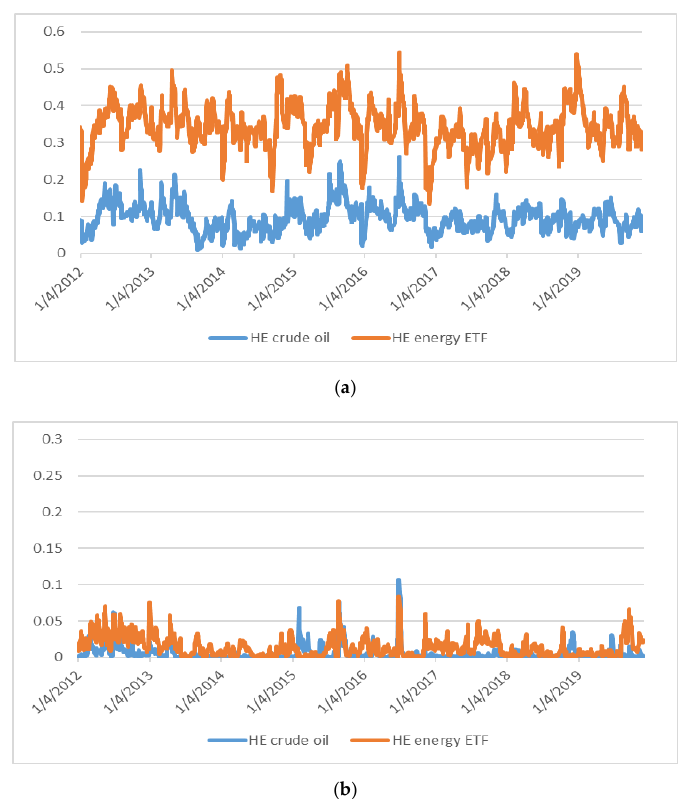
Figure 3. Hedge effectiveness between green bonds and each of the two dirty energy assets. Source: Authors’ calculation. (a) clean energy stocks and dirty assets. (b) green bonds and dirty assets.